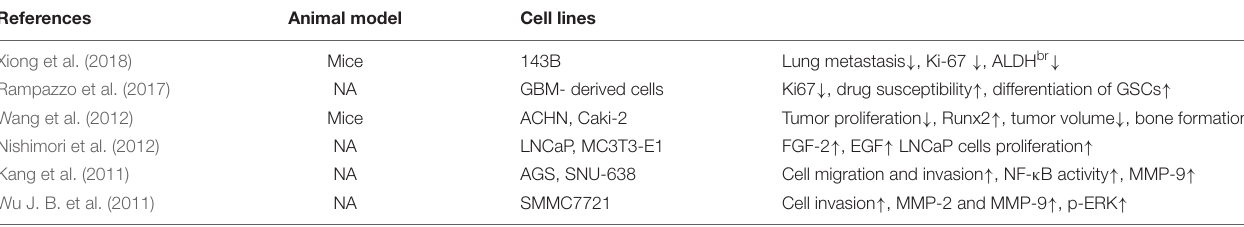
TABLE 1 | Studies of bone morphogenic protein 2 on tumor